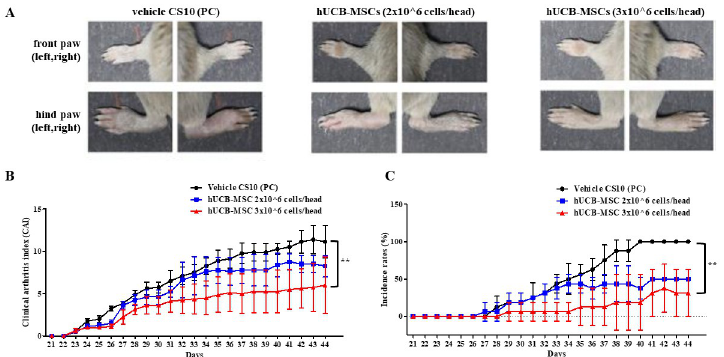
Fig 2. Effects of repeated injection of hUCB-MSCs in type II CIA model. (A) Representative images show gross features of front and hind paws at 44 days after immunization for all three animal groups. (B) Clinical scores of arthritic symptoms assessed by a visual arthritis scoring system were plotted daily until 44 days (n = 4 for each group). (C) Incidence rates of vehicle CS10 and hUCB-MSCs treated mice were plotted daily until 44 days (n = 4). Each point on the graph is presented as mean ± SD. Normality tests were performed using the Shapiro-Wilk normality test. Statistical significance versus vehicle CS10-treated CIA control group (as a control group) was determined by Kruskal- Wallis test with Dunn’s multiple comparisons test ( �� p <